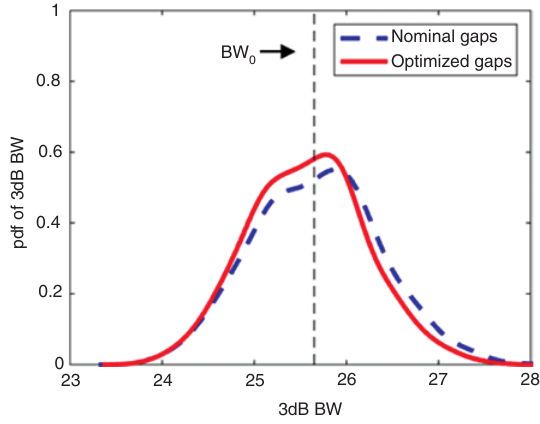
Figure 5: 3 dB bandwidth pdfs of the unoptimized nominal design (nominal gaps